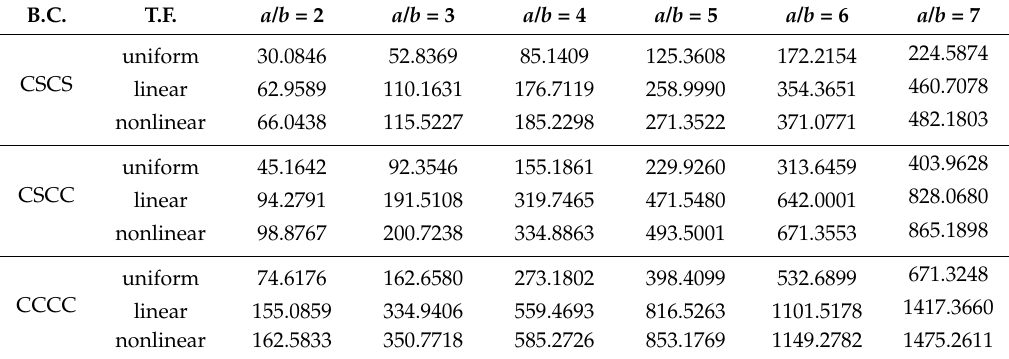
Table 11. Critical buckling temperature ∆ T cr of type-I FGM rectangular thin plate with different a / b and various B.C. ( a / h = 100, n = 2, T 0 = 300 K).